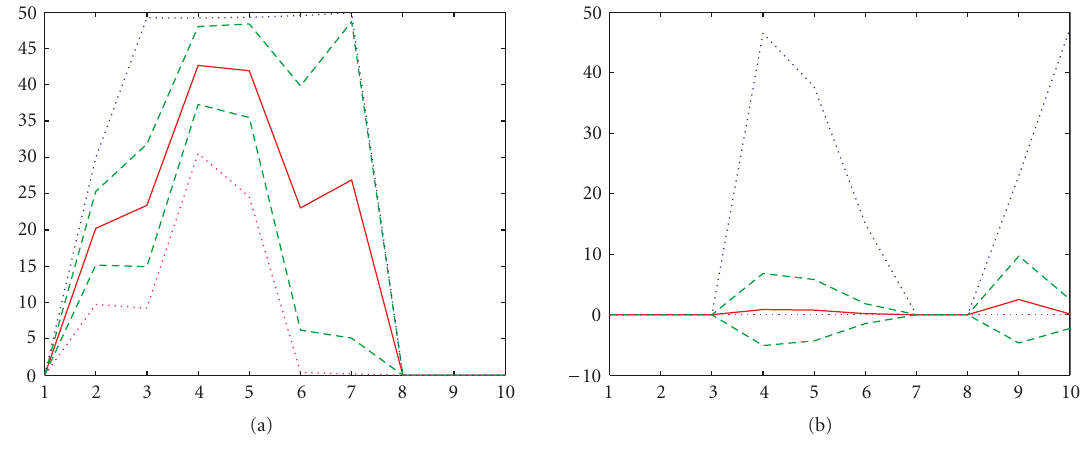
Figure 14: Transversal error for the architecture without (a) and with (b) agent